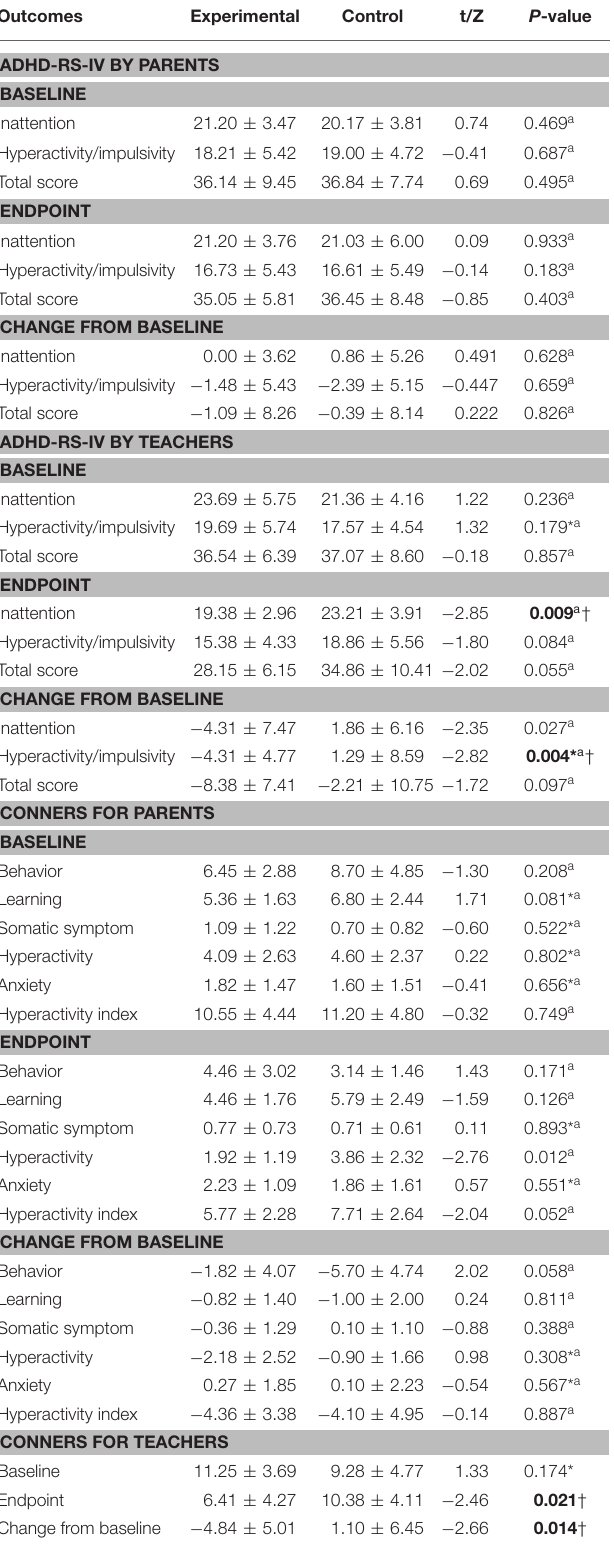
TABLE 2 | Summary of outcomes at baseline and endpoint by group. Outcomes